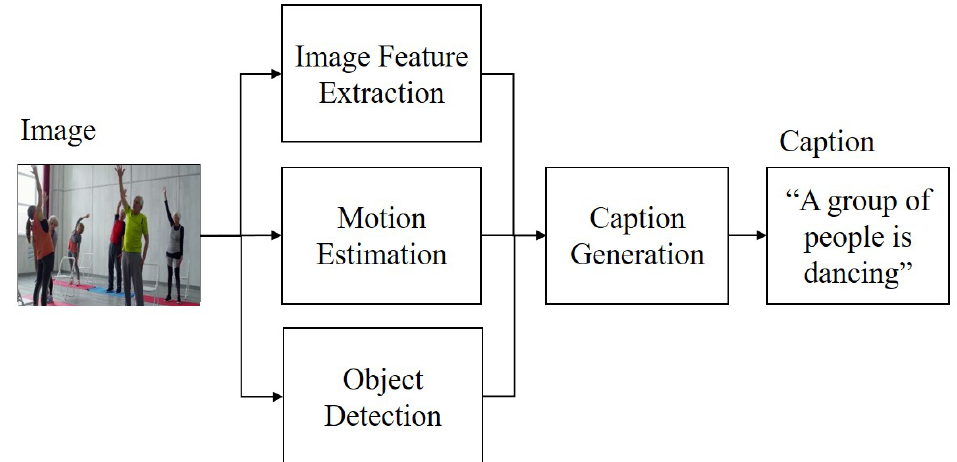
Figure 1. Overview of proposed model. An input image is passed to image feature extraction, motion estimation and object detection components for incorporating image and motion features. Then, the caption generation component is applied for caption